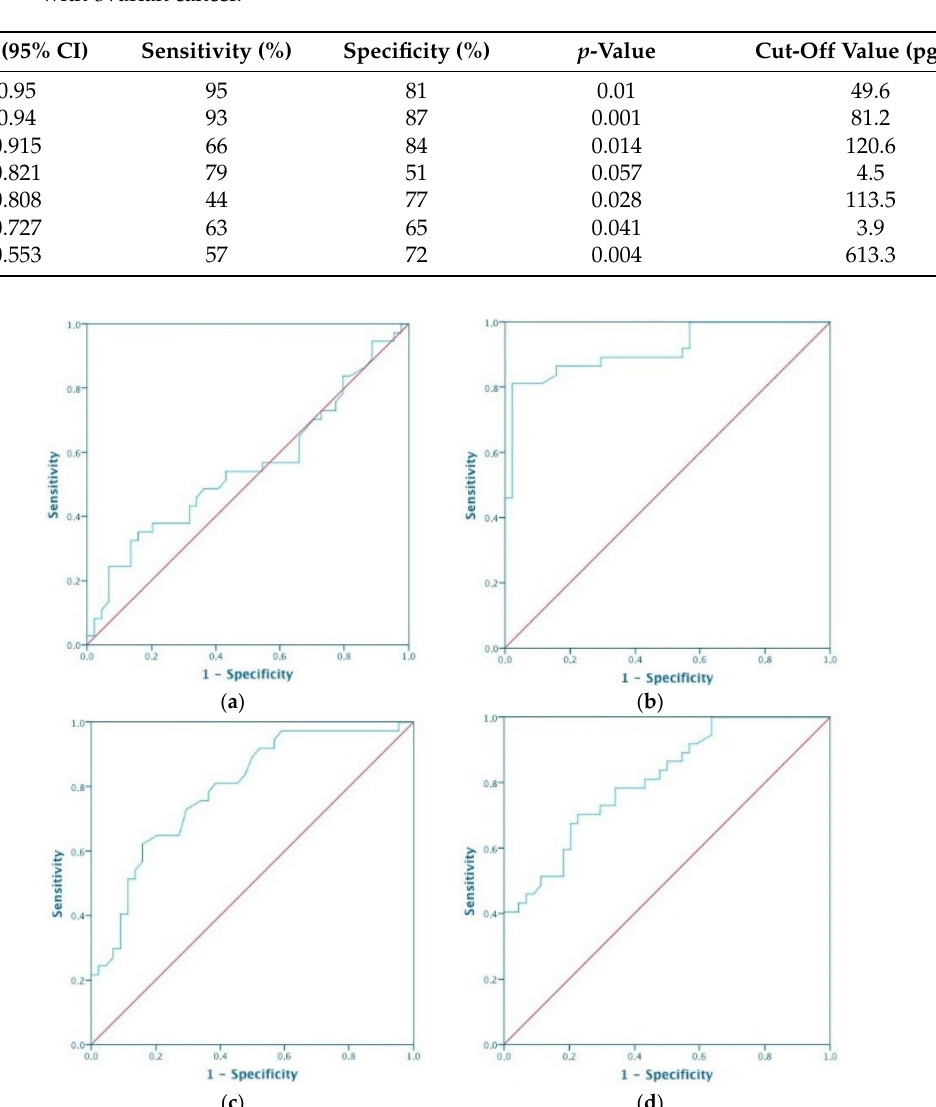
Figure 1. Table 11. The diagnostic values of BTLA, CD27, CD70, CD28, CD80, CA125 and HE4 for patients with ovarian cancer.